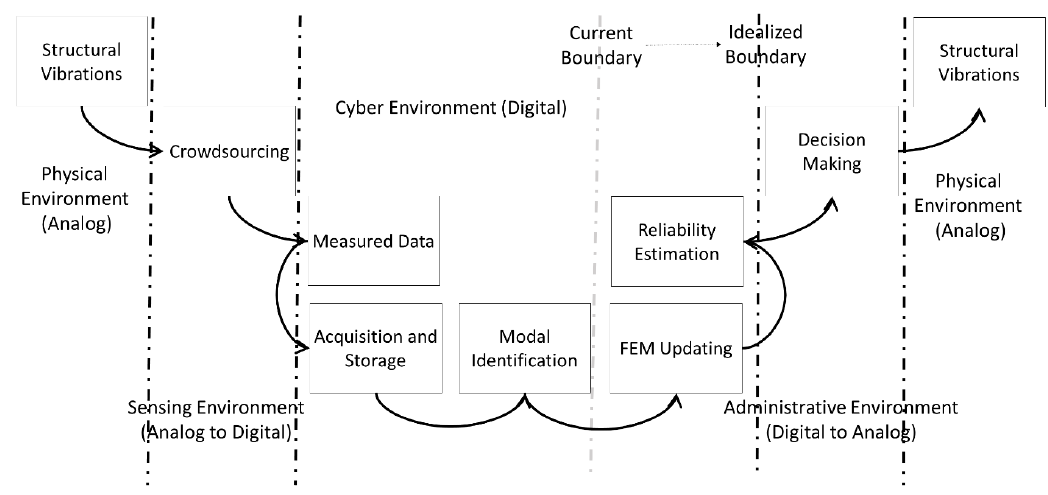
Figure 1. Cyber-physical processes of CS4SHM system.